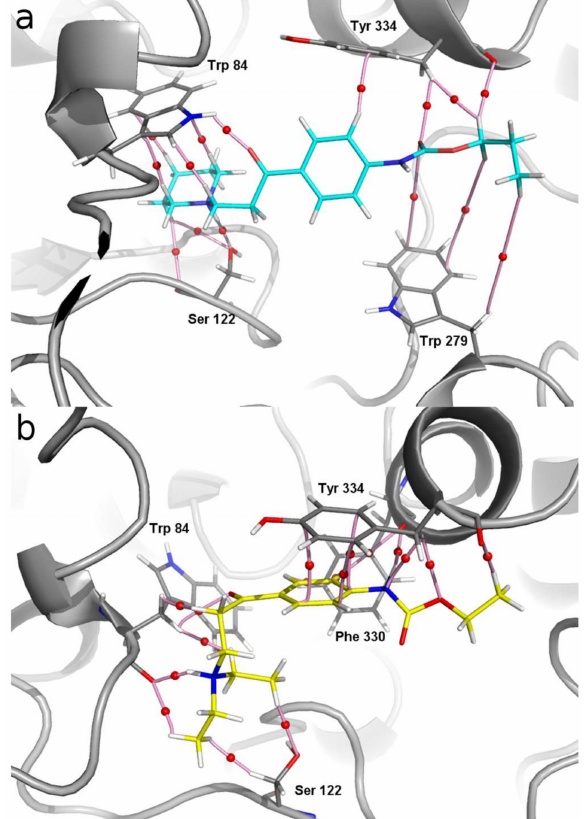
Figure 4. Molecular graph of the non-covalent interactions between the main residues of AChE with ( a ) compound 3 (light blue sticks) and ( b ) compound 6 (yellow sticks). The elements of the electron density topology are shown. The bond paths connecting the nuclei are represented in pink sticks and the bond critical points are shown as red